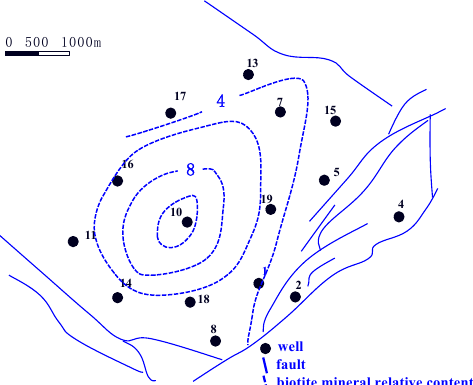
Figure 7. Thin section micrographs of the PL granite buried-hill. The ( left ) figure shows the thin section of Well 13, with a depth of 1502.8 m and a granodiorite lithology; the ( right ) picture shows the thin section of Well 2, with a depth of 1346 m and which is monzogranite.